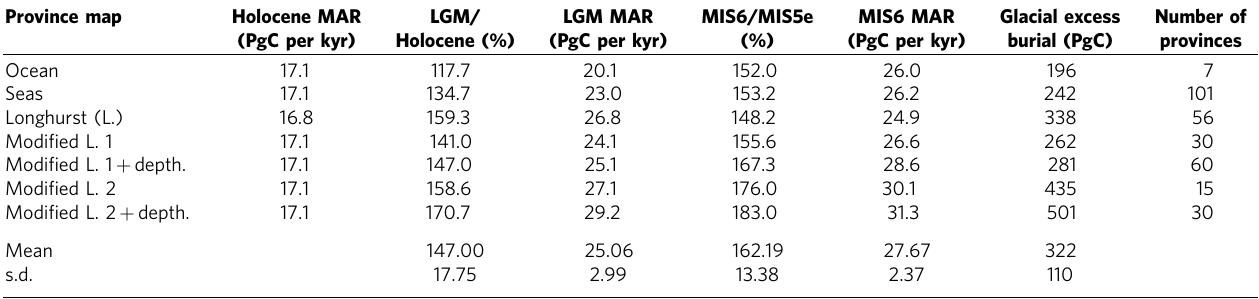
Table 1 | Changes in organic carbon burial over the two last glacial–interglacial transitions. Province